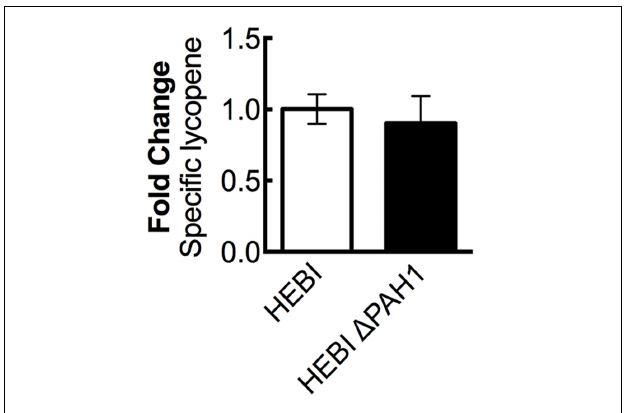
FIGURE 4 | The effect of PAH1 knockout on lycopene production in Y. lipolytica PO1f. Relative specific lycopene content of strains with and without disruption of PAH1 . Strains were grown for 4 days in 25 mL of YPD10 at 30 ◦ C in baffled shake flasks. Bars and error bars represent the mean and standard deviation, respectively, of biological triplicates. Statistical significance from the HEBI strain is indicated by “ ∗ ”. No statistically significant difference was detected. The HEBI strain produced 5.3 ± 0.3 mg lycopene/g DCW.